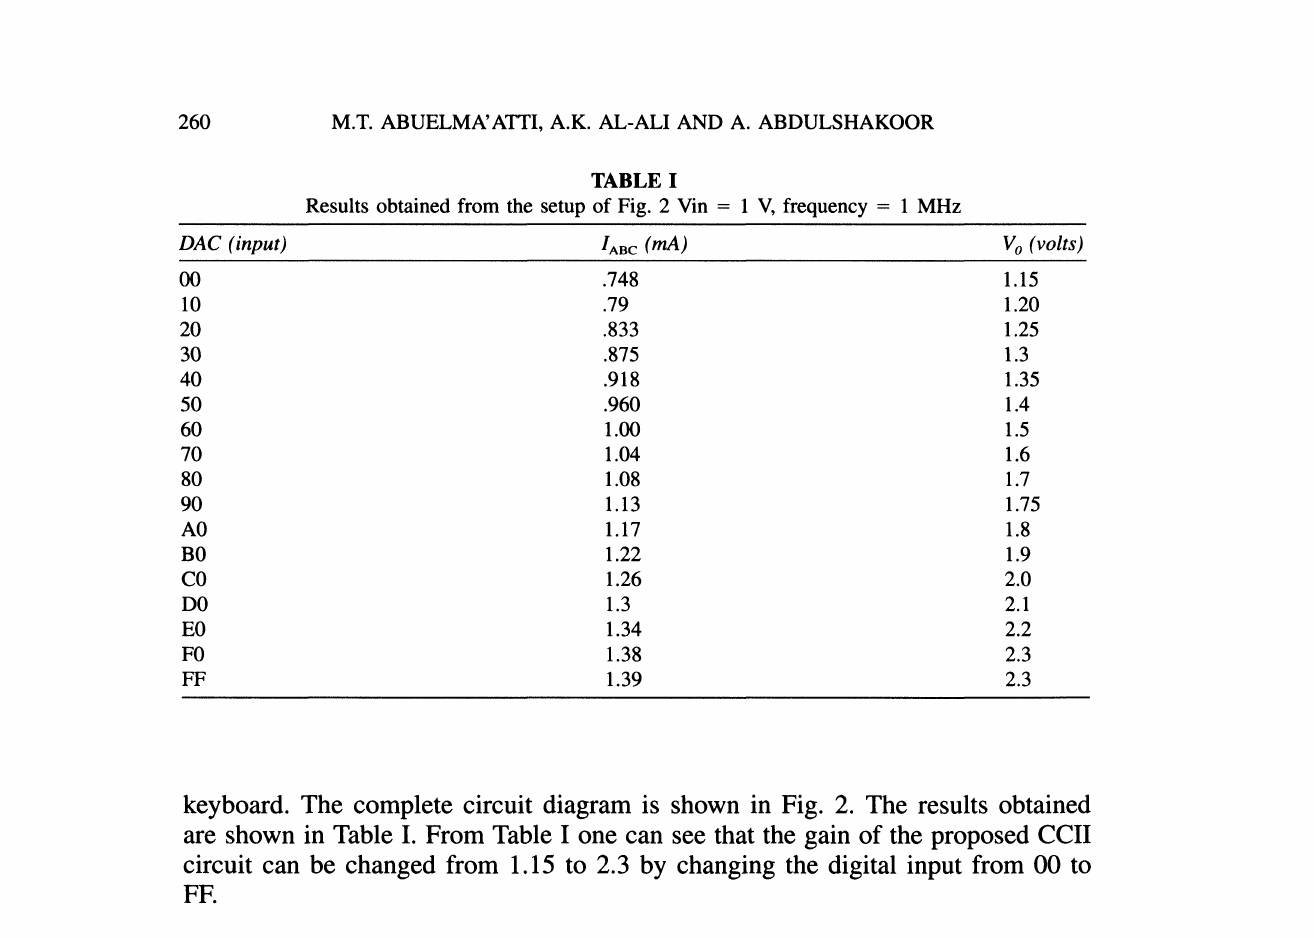
Results obtained from the setup of Fig. 2 Vin V, frequency MHz IABC (mA) V